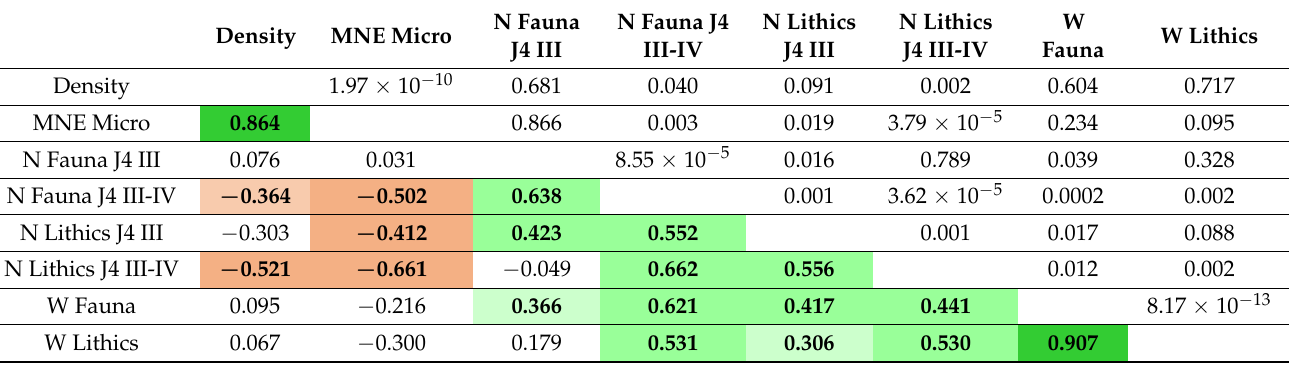
Table 3. Pearson’s r correlation coefficient (lower left part of the table) and associated p -values (upper right part of the table) for different variables along the spit sequence. Coefficient values in bold are associated with a significant p -value at the 5% threshold. Negative correlations in orange, positive correlations in green, the darker shades indicate stronger correlations. N = number of remains and W = weight of faunal remains and lithic artefacts recovered from the sieve residues (g/L). “Density” corresponds to the density of micromammal remains (MNE/L); “MNE micro” refers to micromammals and “fauna” to